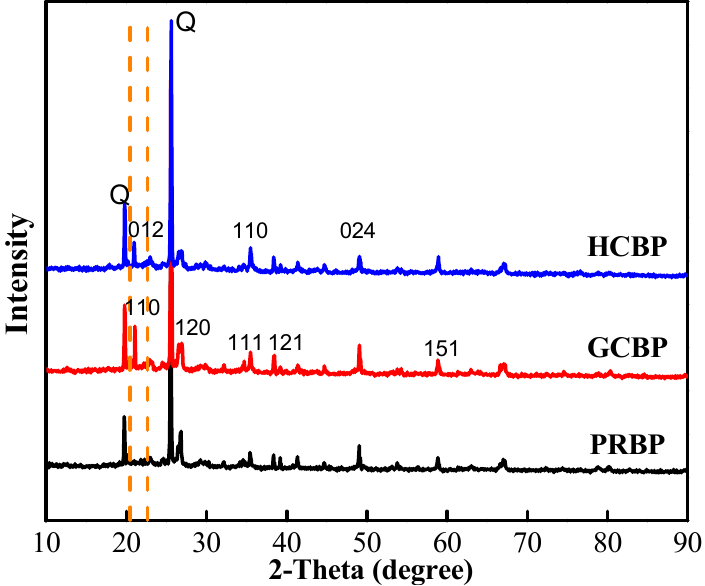
Figure 2. The X-ray diffraction patterns of PRBP, GCBP, and HCBP.